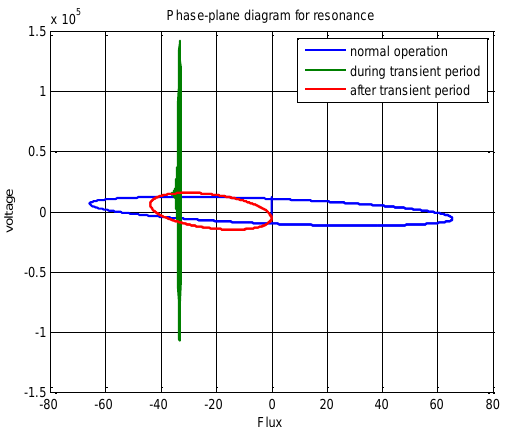
Fig. 33. Phase-plane diagram (  -v) for phase-c secondary due to resonance for the studied power transformer.